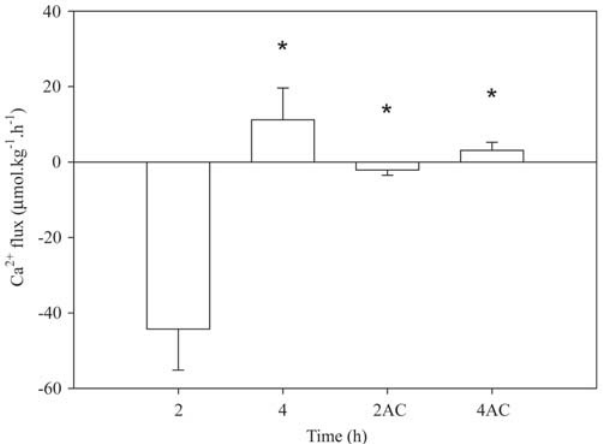
Fig. 1. Net Ca 2+ fluxes of Hoplosternum littorale exposed to well water as a function of time after transfer from tanks of ion-poor well water. Data expressed as mean ± SEM. Positive values indicate net influxes and negative values net effluxes. AC - after change. Asterisks (*) indicate significantly different from 2 h by Kruskall-Wallis ANOVA and Mann-Whitney test (P < 0.05).